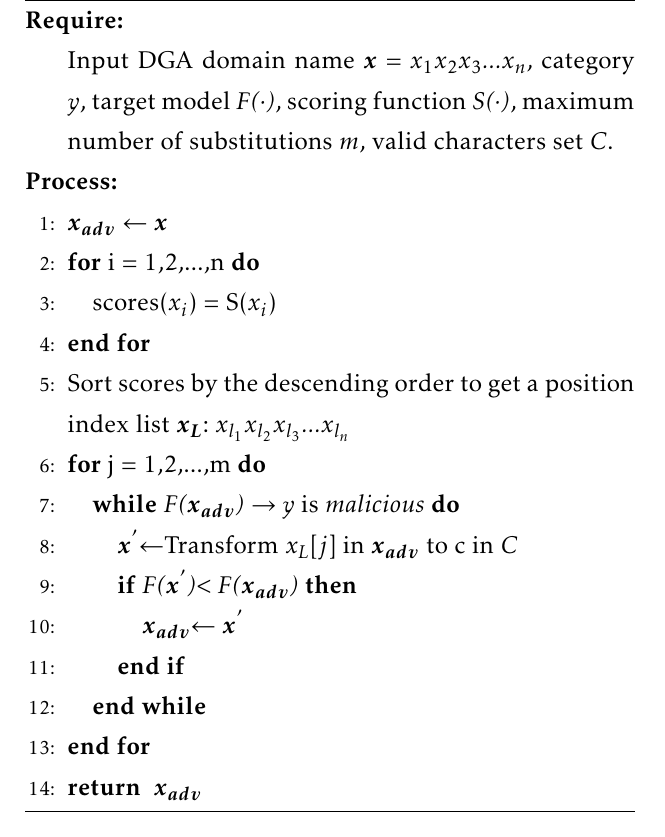
Algorithm 1 Adversarial Attack by